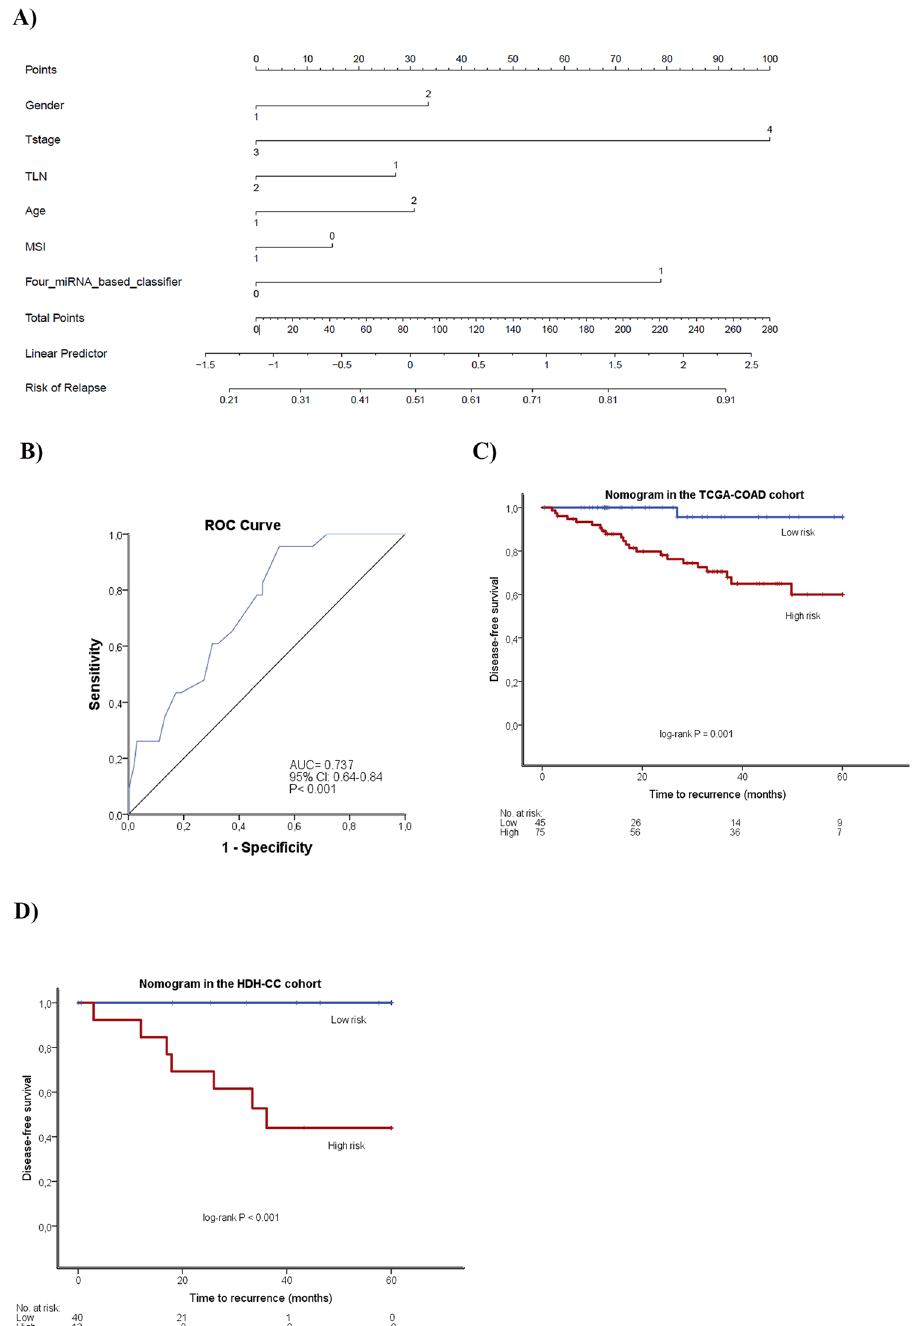
Figure 2. Nomogram based on gender (1 = women, 2 = men), Tstage (3 = T3, 4 = T4), TLN ( < 12 = 1, ≥ 12 = 2 Total Number of Lymph nodes), age (median age), MSI (0 = MSI, 1 = MSS) and the four-miRNA classifier ( A ). ROC curve analysis of Risk of Relapse calculated using the nomogram in the TCGA-COAD ( B ). Kaplan-Meier plots for 5-year DFS according to the nomogram in the TCGA-COAD ( C ) and HDH-CC ( D )